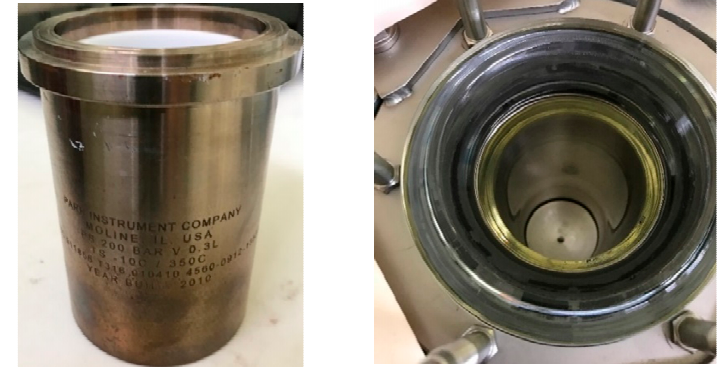
Figure 4. Parr Autoclave with maximum pressure of 200 bar and maximum temperature of 250 °C.